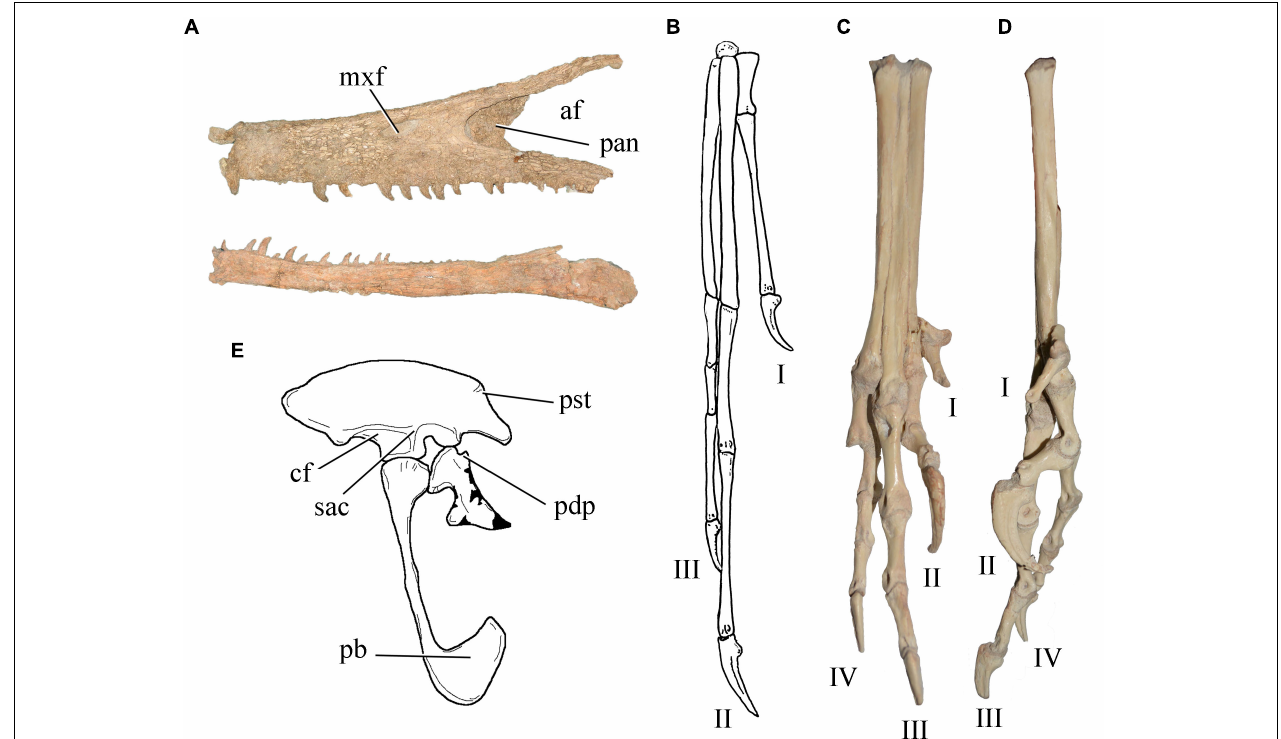
FIGURE 5 | Selected unenlagiid traits: (A) maxilla and dentary of Austroraptor cabazai showing the rostral process of the maxilla, the anteroposteriorly elongated postantral wall, and the sub-parallel dorsal and ventral margins of the dentary; (B) elongate left manus of Buitreraptor gonzalezorum (modified from Novas et al., 2018); dorsal (C) and medial (D) views of Buitreraptor gonzalezorum pes showing slender and gracile metatarsals, sub-equal lengths of metatarsals II and IV, and modified digit II (MPCA-PV-598); (E) reconstruction of Unenlagia comahuensis pelvic girdle (modified from Novas and Puerta, 1997) indicating the proximodorsal process, pronounced supracetabular crest, and sub-triangular pubic boot. af, antorbital fenestra; cf, fossa for M. cuppedicus ; mxf, maxillary fenestra; pan, postantral wall; pb, pubic boot; pdp, proximodorsal process; pst, processus supratrochantericus; rpmx, rostral process of maxilla; sac, supracetabular crest. Not to scale.